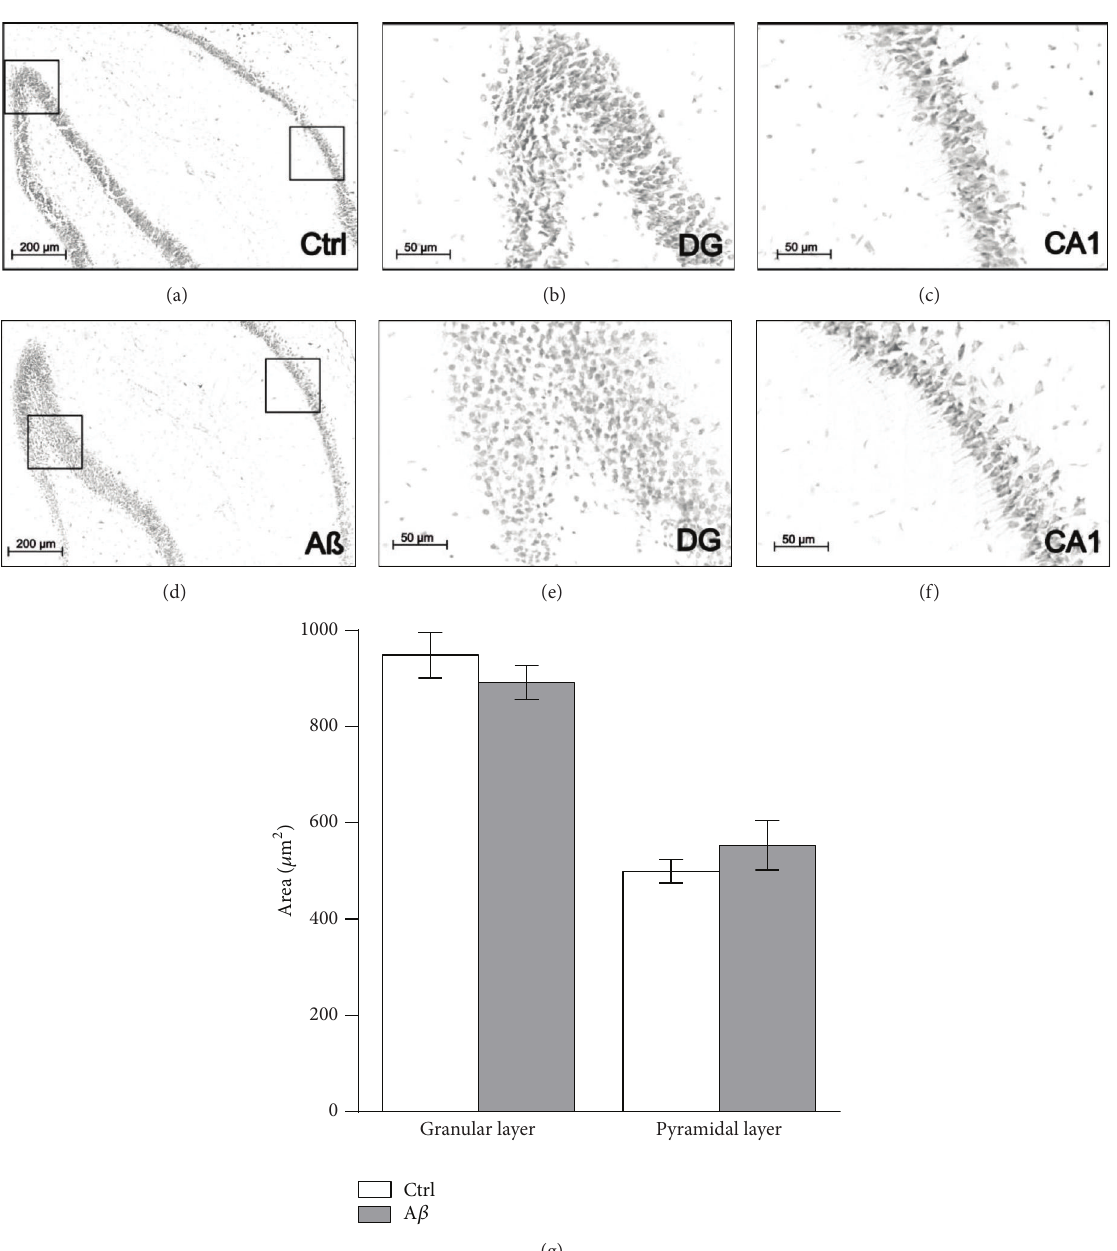
Figure 1: A 𝛽 does not affect hippocampal integrity. ((a)–(f)) Representative microphotographs of hippocampal sections obtained from animals injected with vehicle ((a)–(c)) or 400 pmoles of A 𝛽 ((d)–(f)). ((a) and (d)) Panoramic view of the hippocampus (10x). ((b) and (e)) Magnification of the dentate gyrus (40x) from the area enclosed in the squares shown in (a) and (d), respectively. ((c) and (f)) Magnification of the CA1 region (40x) from the area enclosed in the squares shown in (a) and (d), respectively. (g) Quantification of the area (mean ± S.E.M) of the granular cell layer and the pyramidal cell layer from sections of animals injected with vehicle (Ctrl) or 400 pmoles of A 𝛽 ( 𝑛 = 10/group). Note that A 𝛽 injection does not modify hippocampal integrity measured as the granular or pyramidal area.